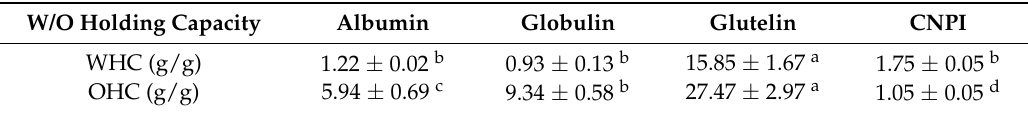
Figure 4. Solubility-pH profiles ( A ) and photograph of solubility ( B ) of cashew nut protein fractions compare with CNPI in different pH (3, 5, 7, 9). Table 4. Water/Oil holding capacity of cashew nut protein fractions compare with CNPI in neutral environment.